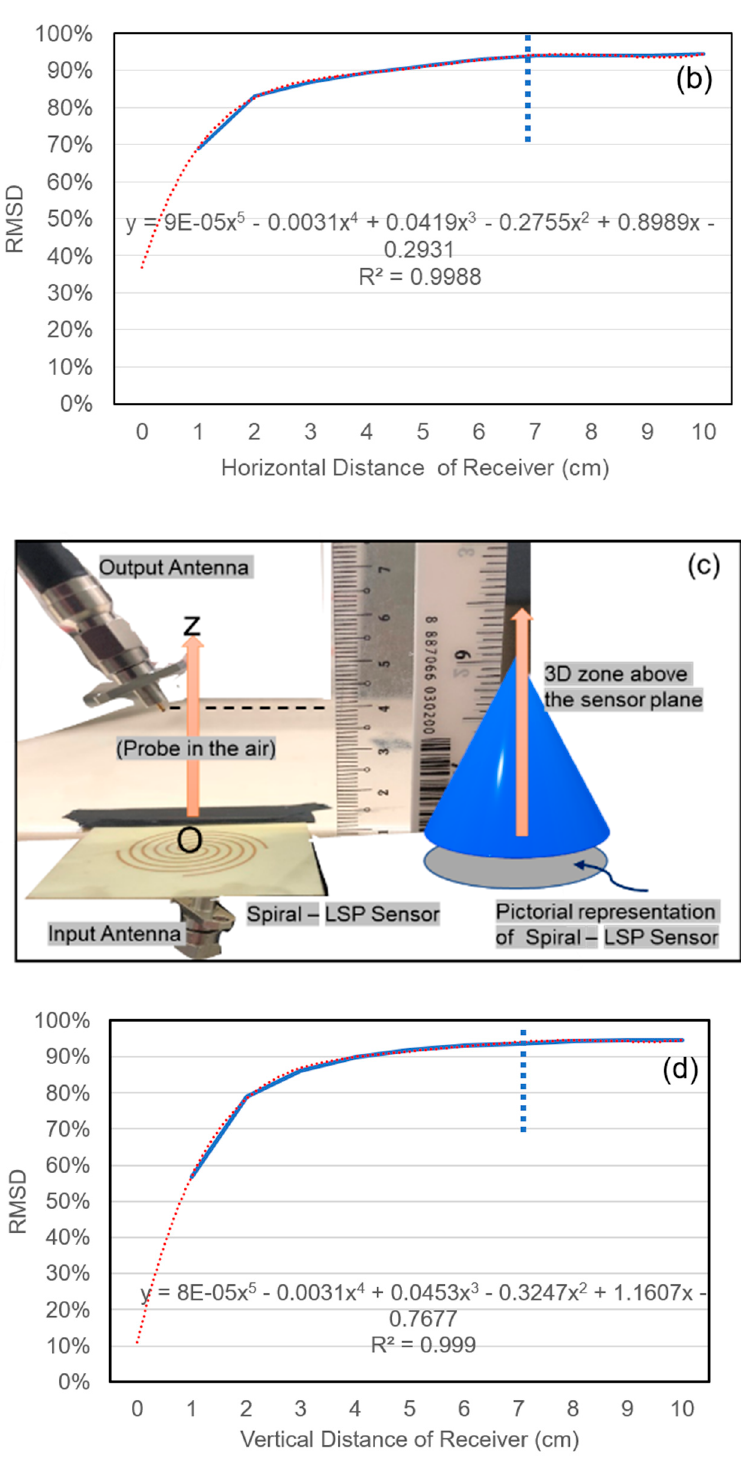
Figure 4. Representative LSP sensing zone study ( a ) horizontal radius of sensing, ( b ) RMSD variation of output signals in X-axis, ( c ) vertical radius of sensing, and ( d ) RMSD variation of output signals in Z-axis.